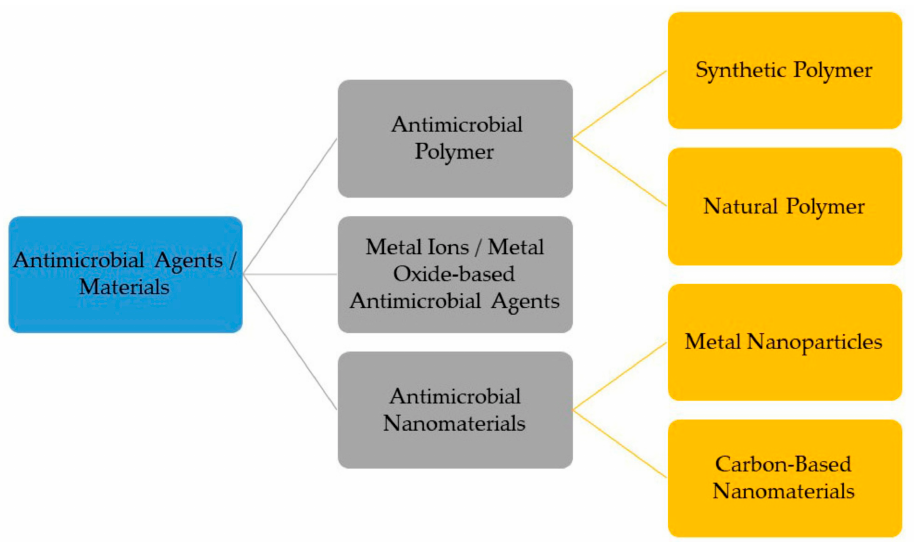
Figure 3. Classification of current antiviral surface coating materials (adapted with permission from Nasri et al. [39]).